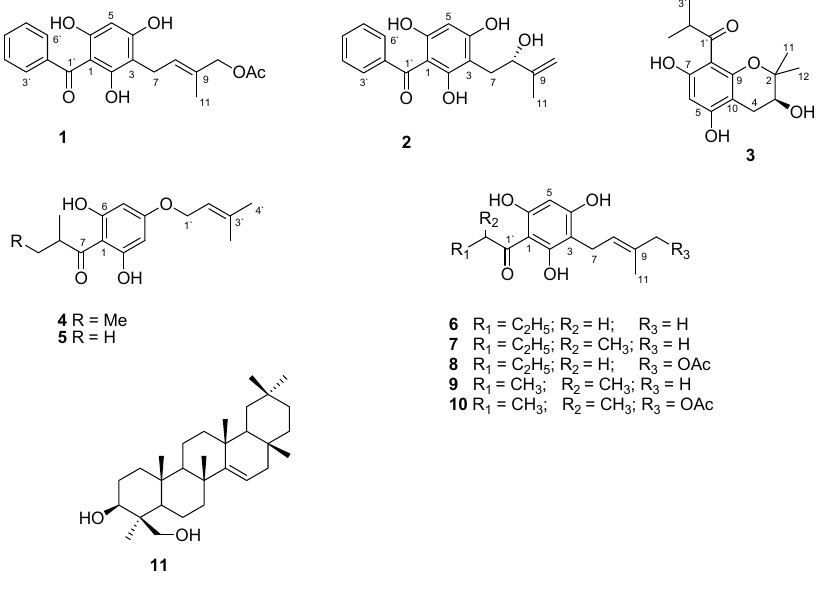
Figure 1. Chemical structures of compounds 1 – 11 isolated from H. niveum